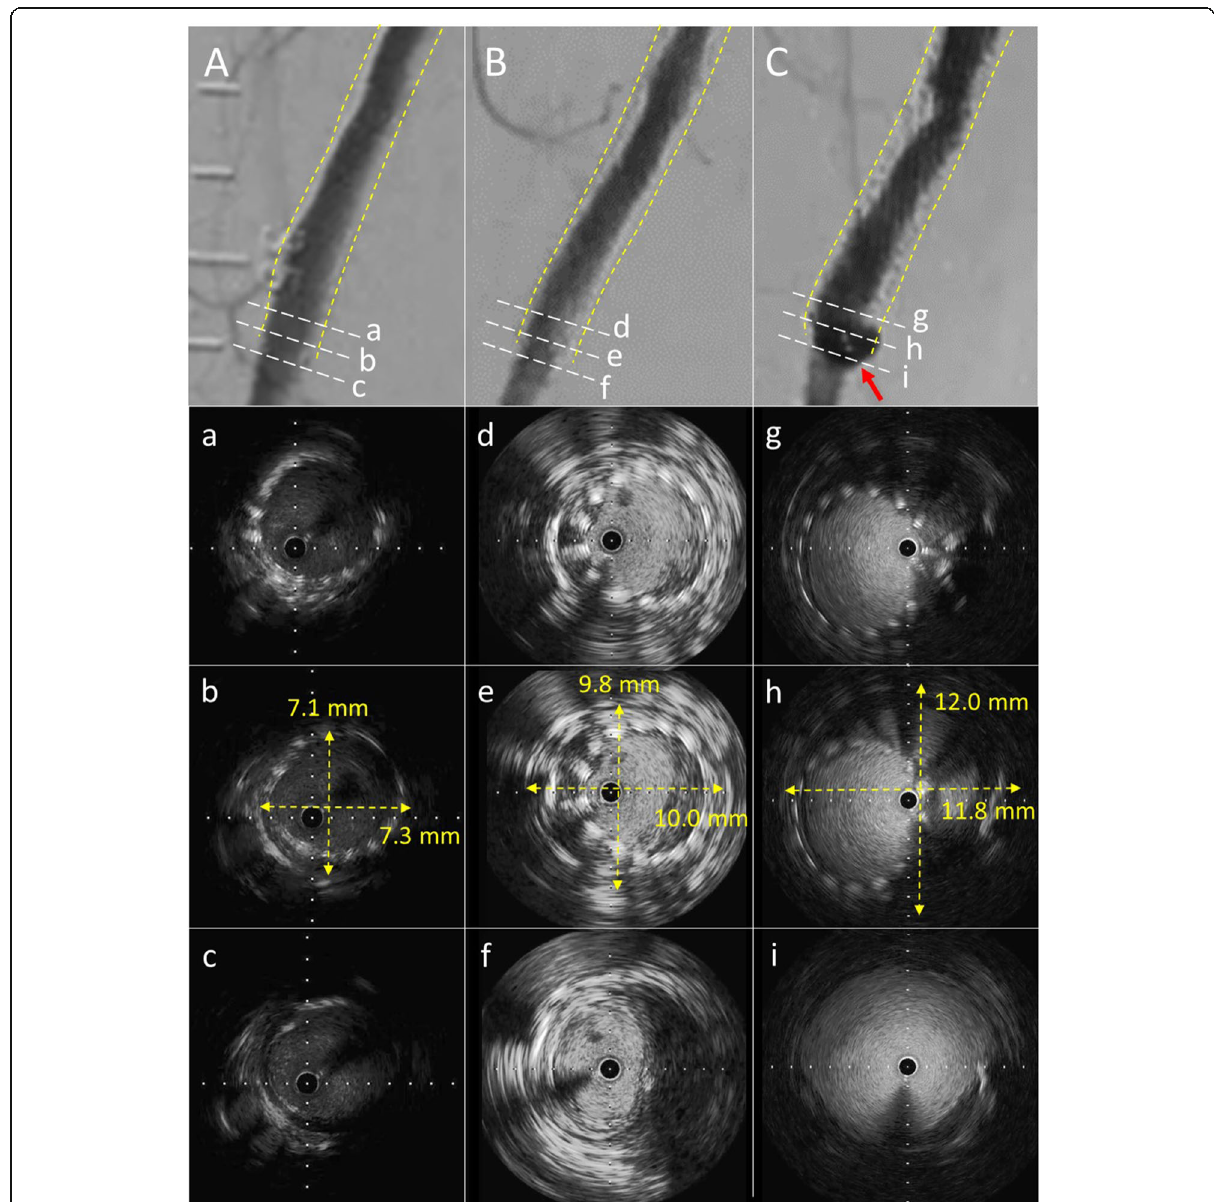
Fig. 2 Conventional angiogram and intravascular ultrasound (IVUS) immediately, 25 months, and 50 months after drug-eluting stent (Eluvia) placement. A: Angiography immediately after drug-eluting stent (Eluvia) placement. Angiography showing optimal expansion. B: Angiography 25 months after drug-eluting stent (Eluvia) placement. Angiography showing no significant stenosis or peri-stent contrast staining in the distal part of the right superficial femoral artery. C: Angiography 50 months after drug-eluting stent (Eluvia) placement. Angiography demonstrating peri- stent contrast staining in the distal part of the drug-eluting stent (Eluvia) placement site (red arrow). a-c: Images of IVUS immediately after drug- eluting stent (Eluvia) placement. IVUS demonstrating optimal expansion of drug-eluting stent (Eluvia) (a-c). Maximum vessel diameter was 7.3 mm at the distal edge of the drug-eluting stent (Eluvia) placement site (b). d-f: Images of IVUS 25 months after drug-eluting stent (Eluvia) placement. IVUS revealing vessel enlargement with a maximum vessel diameter of 10.0 mm at the distal edge of the drug-eluting stent (Eluvia) placement site (d-f). g-i: Images of IVUS 50 months after drug-eluting stent (Eluvia) placement. IVUS showing further enlargement of the maximum vessel diameter to 12.0 mm at the distal edge of the drug-eluting stent (Eluvia) placement site (g-i). Enlargement of the lumen and stent malapposition (g and